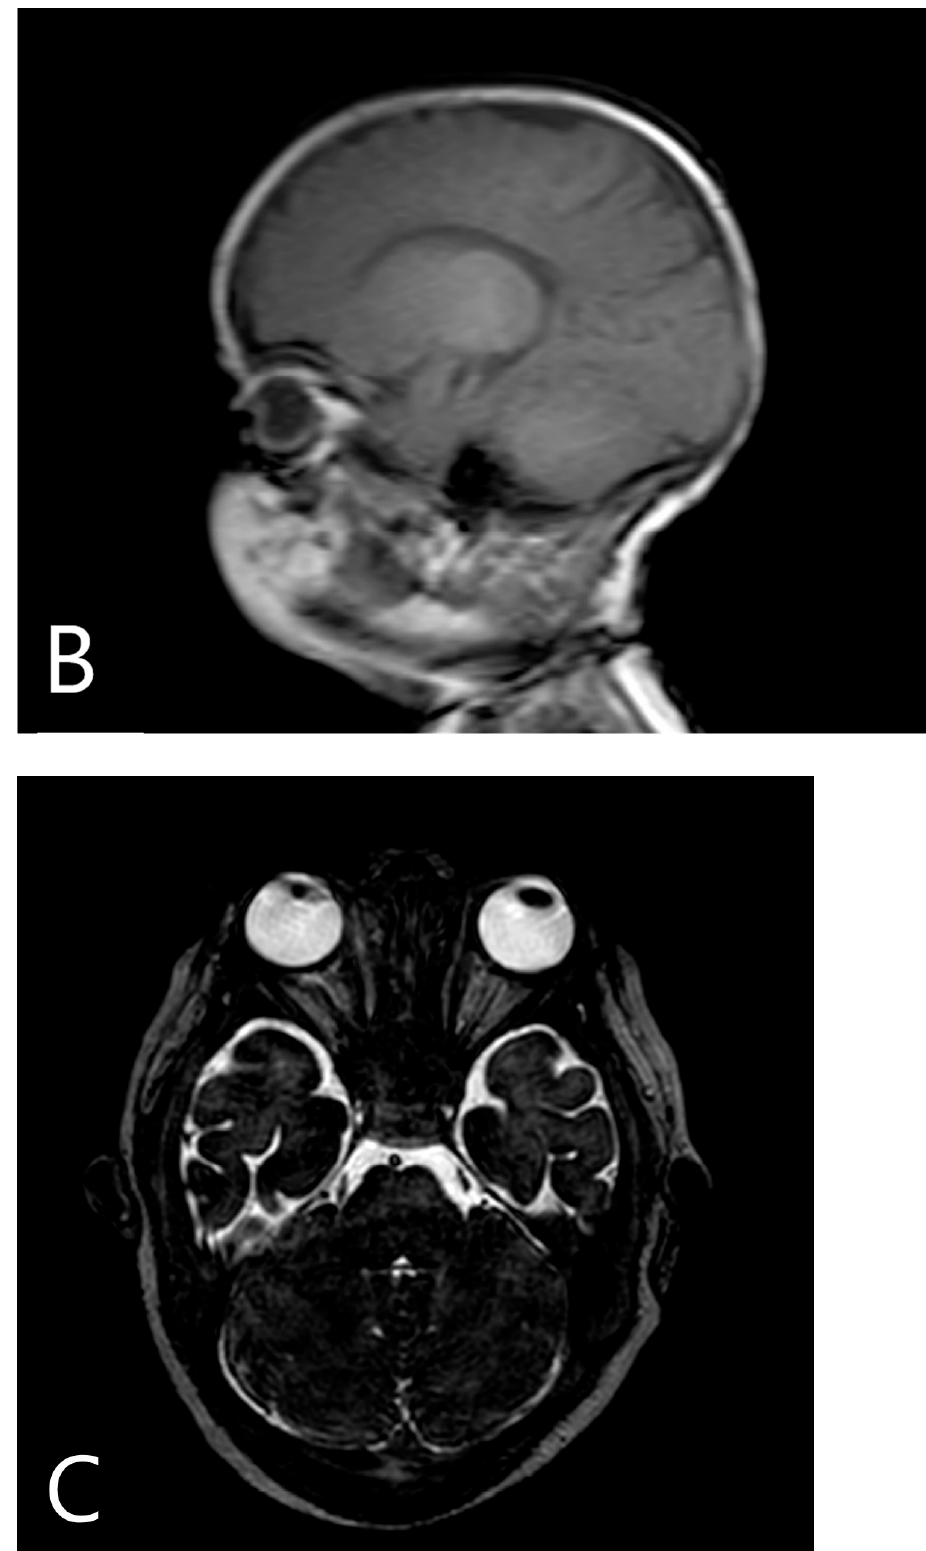
Figure 1. Pre-transplantation radiography ( A ) shows increased bone density, rachitic malformation in ribs, and endobone appearance in vertebrae and humeri. Sagittal T1-weighted MR image ( B ) demonstrates the sclerosis of the calvaria. Axial T2-weighted MR image ( C ) shows optic canal stenosis and optic nerve atrophy.